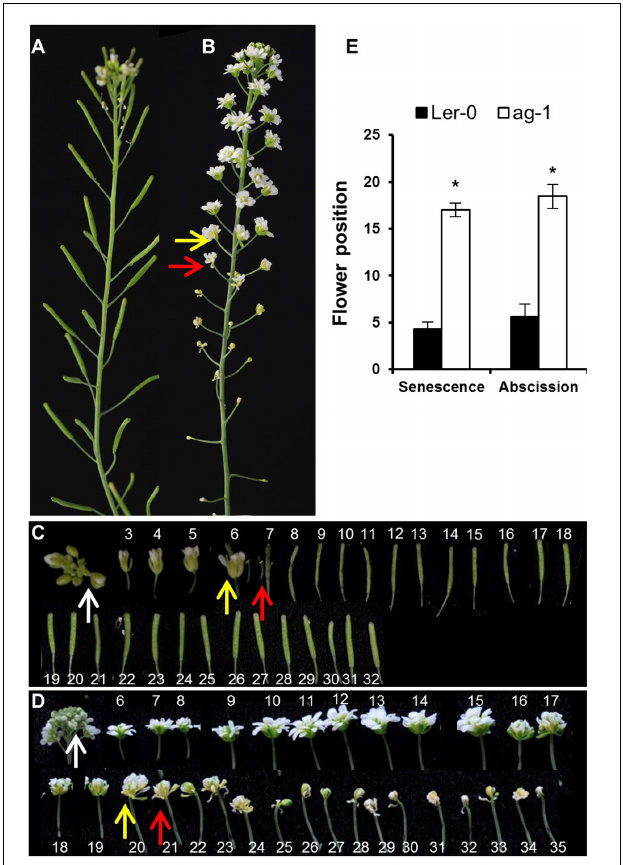
FIGURE 1 | Yellowing and abscission of sepals in L er -0 and ag-1 plants. (A) 8 week-old L er -0 plant. (B) 8 week-old ag-1 plant. (C) L er -0 flowers detached from 8 week-old plant. (D) ag-1 flowers detached from 8 week-old plant. (E) Position of flowers showing yellowing and abscission in 8 week-old L er -0 and ag-1 plants. Plants were grown under long-day conditions for 8 weeks in a growth room (20–22 ◦ C, 16-h light and 8-h dark cycle, white light ∼ 180 µ E and 60% relative humidity) and flowers were detached and subsequently photographed. The yellow and red arrows indicate flowers with senesced and abscised sepals, respectively. The white arrows indicate the flowers used for quantifying delayed sepal senescence for Figure 2D . The flowers are numbered according to the numbering system of Bleecker and Patterson (1997). The numbers in (C,D) indicate the positions of the flowers/siliques along the flowering stalk: flower 1 is the first opened flower present at the top, whereas the high numbers are the flowers/siliques present at the bottom of the stalk. The ag-1 flower is composed of a repeating series of sepal-petal-petal and when whorls of petals abscises, the inner sepal whorl, green in color, appears. This can be seen by reduction in the ag-1 flower size after flower position 20 in (D) . The photographs shown are representative of six to eight biological replicates. The error bars indicate standard errors of the mean of eight biological replicates. ∗ Indicates statistically significant ( p < 0.05) between L er -0 and ag-1 using Student’s t -test.